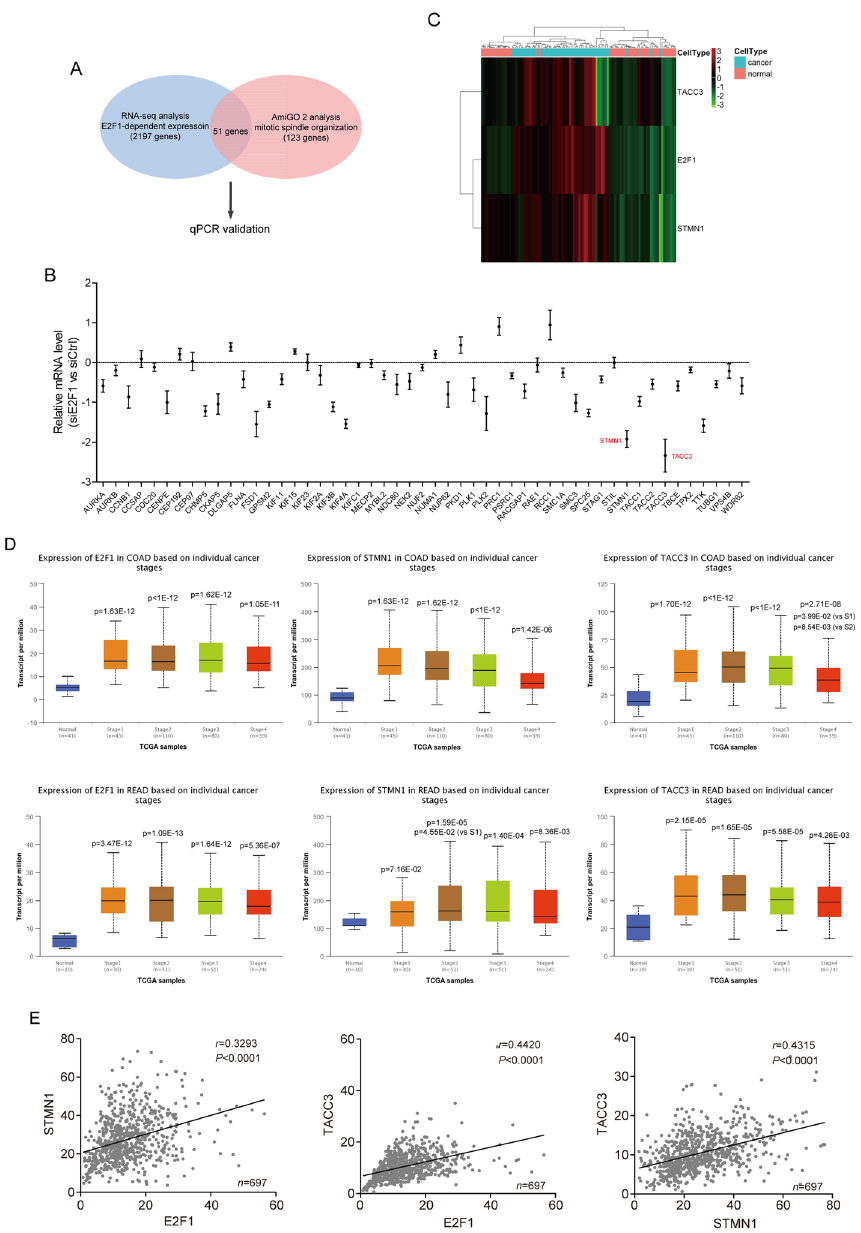
Fig. 1 E2F1 is positively correlated with stathmin1 and TACC3 in pathological tissues derived from CRC patients. A Differential expression of genes in CRC cells with and without knockdown of E2F1 expression and screening for genes associated with mitotic spindle organization. The 51 screened genes were verified by qPCR. B qPCR analysis of relative mRNA levels encoded by these 51 genes in HCT116 cells with and without E2F1 knockdown for 48 h. C Differential expression of E2F1, stathmin1, and TACC3 in 104 pairs of CRC tumor and adjacent normal colorectal tissues, based on the TCGA database. Red color represents increased expression and green indicates reduced expression. Expression was normalized using (level case -mean row )/ SD row . D Effects of cancer stage on levels of expression of E2F1, stathmin1, and TACC3 in 315 COAD and 166 READ cases from the TCGA database and analyzed by UALCAN (http:// ualcan. path. uab. edu/ analy sis. html). The P -values (versus normal) were shown without indications and the P -values (versus Stage 1 and Stage 2) were indicated as S1 and S2 COAD colon adenocarcinoma, READ rectum adenocarcinoma E Correlations among E2F1, stathmin1, and TACC3 levels in 698 CRC (including COAD and READ) pathological tissue samples from the TCGA database, as determined by linear correlativity. Pearson’s test was used to analyze the